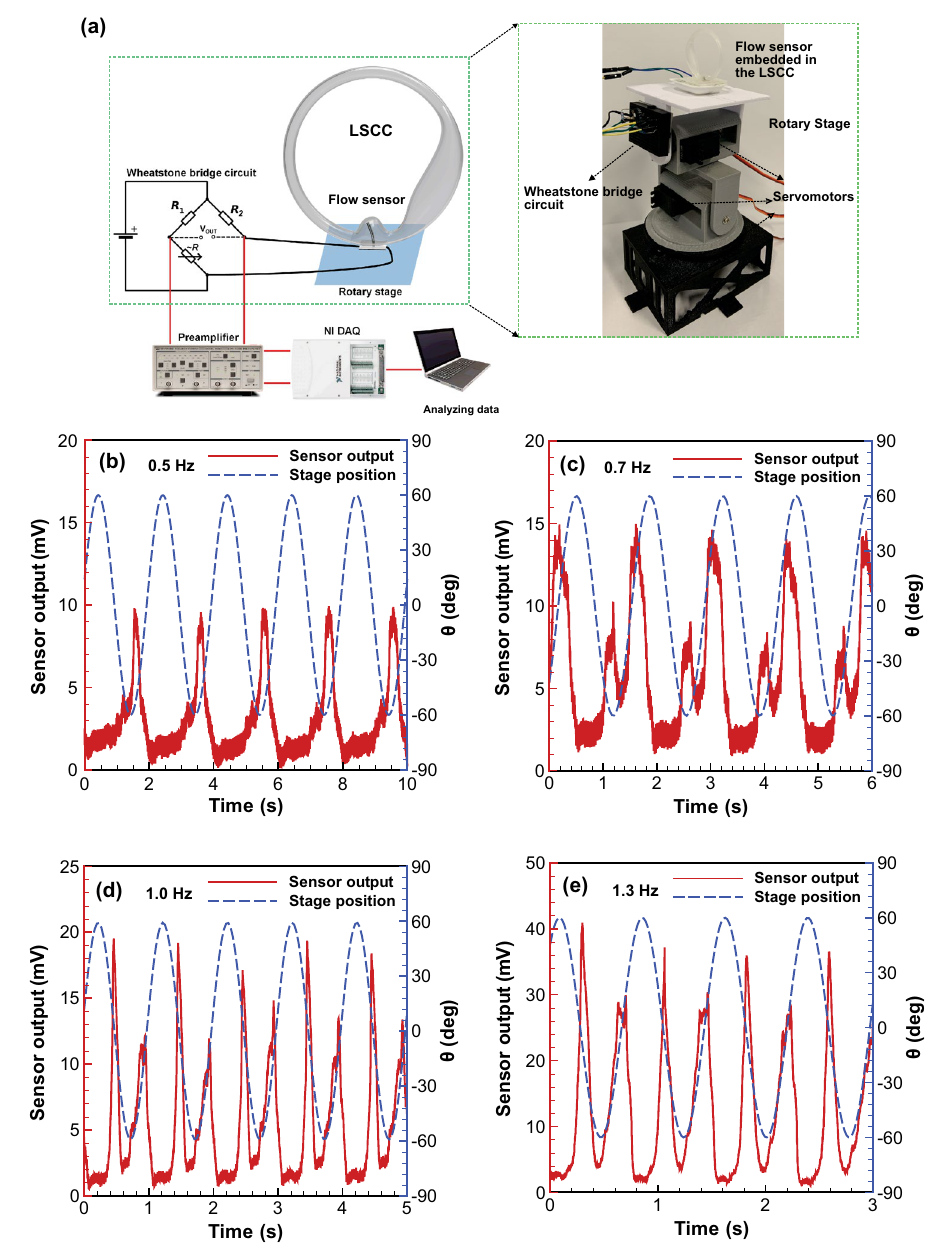
Fig. 6 a Schematic diagram of the experimental setup, and sensor-stage position for 60-degree amplitude and various frequencies: b 0.5 Hz, c 0.7 Hz, d 1 Hz, and e 1.3